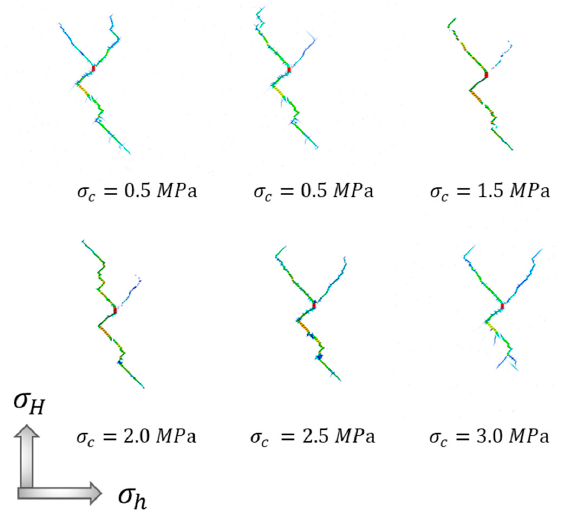
Figure 14. Schematic diagram of fracture morphology in different tensile strength of rock. ( a ) 3 MPa. ( b ) 6 MPa. ( c ) 9 MPa.